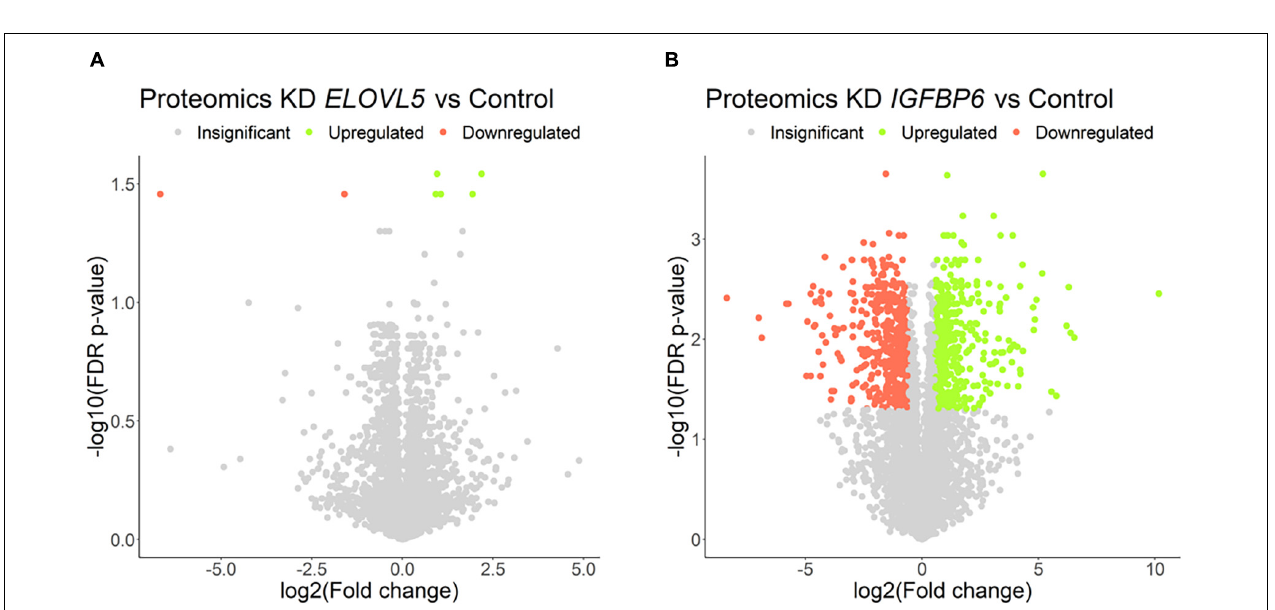
FIGURE 8 | Volcano plots for comparative proteome analysis of the cells with a stable knockdown of (A) ELOVL5 and (B) IGFBP6 genes. Thresholds: Fc = 1.5, FDR p -value = 0.05.